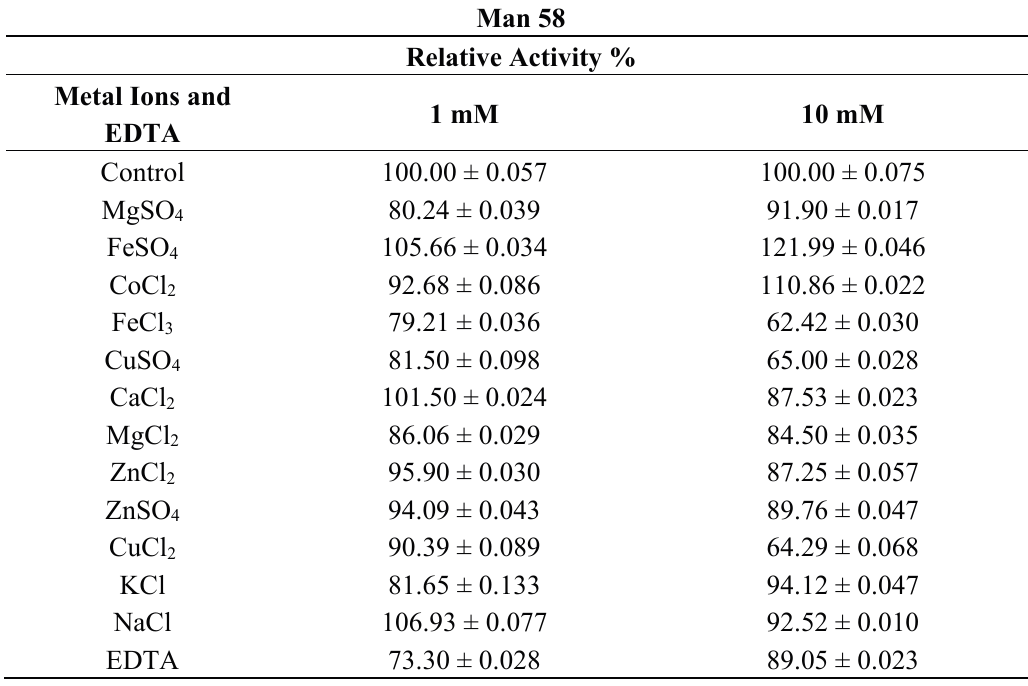
Table 1. The effect of metal ions and ethylenediaminetetraacetic acid (EDTA) in activity of Man 58.